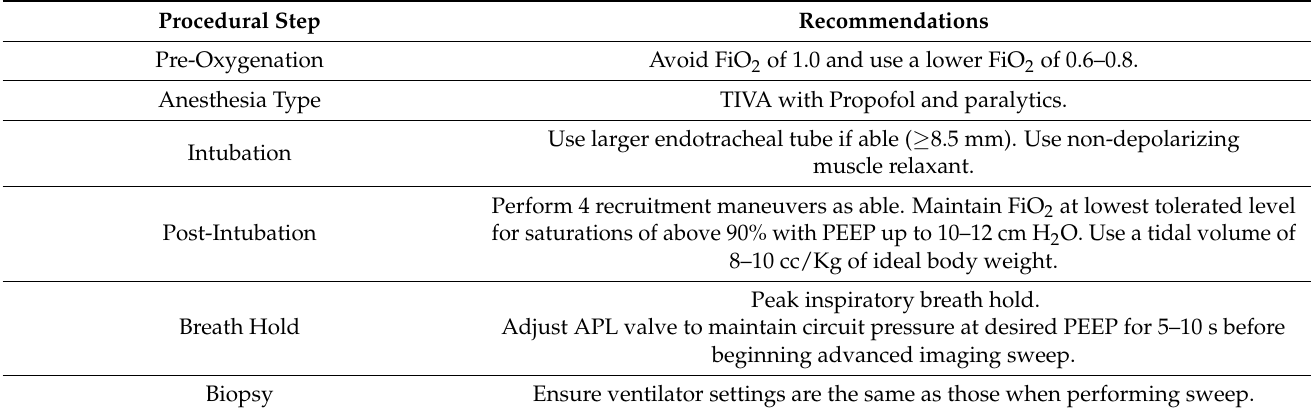
Table 2. Anesthesia recommendations for advanced guided bronchoscopy. Adapted from Pritchett et al.